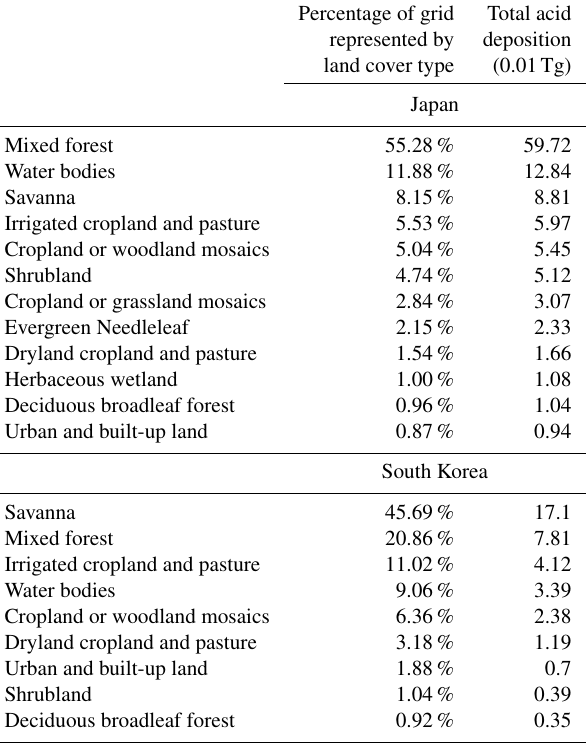
Percentage of grid Total